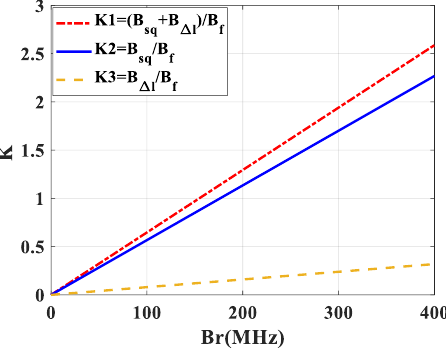
Figure 9. The extended Doppler bandwidth. 302 As the shape of the 2D spectrum in the squint case is parallelogram, as shown in 303 Figure 10a, de-skewing operation can reduce the total bandwidth of the raw data, as 304 shown in Figure 10b. Therefore, before azimuth multichannel reconstruction, de-skewing 305 was operated in each azimuth channel, and azimuth multichannel reconstruction was op- 306 erated in the 2D frequency domain. The major problem of azimuth multichannel recon- 307 struction in the 2D frequency domain is neglecting the range-variant phase error caused 308 by the strong coupling between Doppler and range frequencies, and this error becomes 309 more obvious in the distributed DPCMAB SAR system. To improve the performances of 310 azimuth multichannel reconstruction and the following 2D focusing, the range-variant 311 phase error should be compensated during multichannel reconstruction. 312